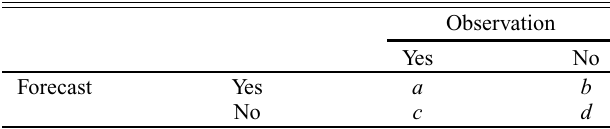
Table 2. Contingency table for a binary